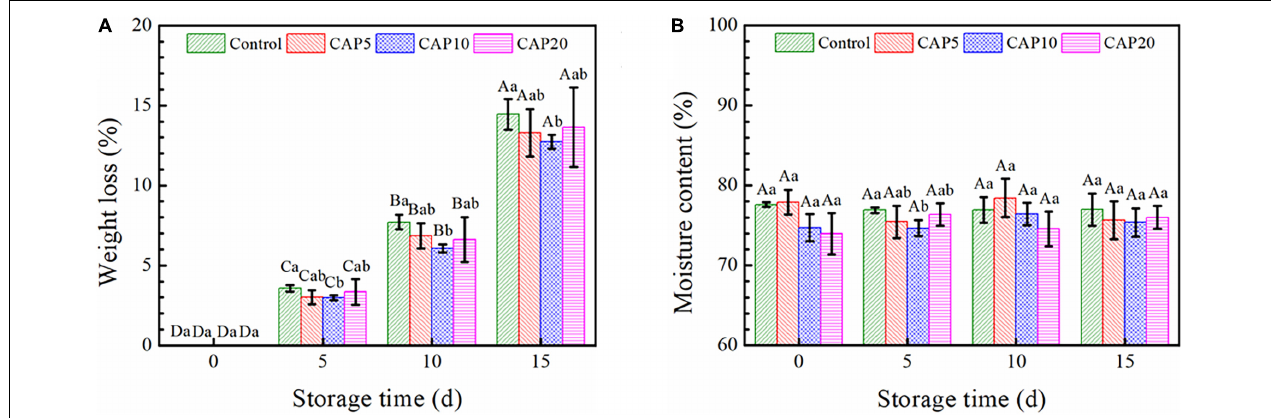
FIGURE 2 | The weight loss (A) and moisture content (B) of jujubes in CAP5, CAP10, CAP20, and control during 15-day storage at 4 ◦ C and 90 % relative humidity (RH). Different small letters indicate significant differences among different groups at the same storage time ( p < 0.05), whereas different capital letters represent significant differences among different storage times within the same group ( p < 0.05).